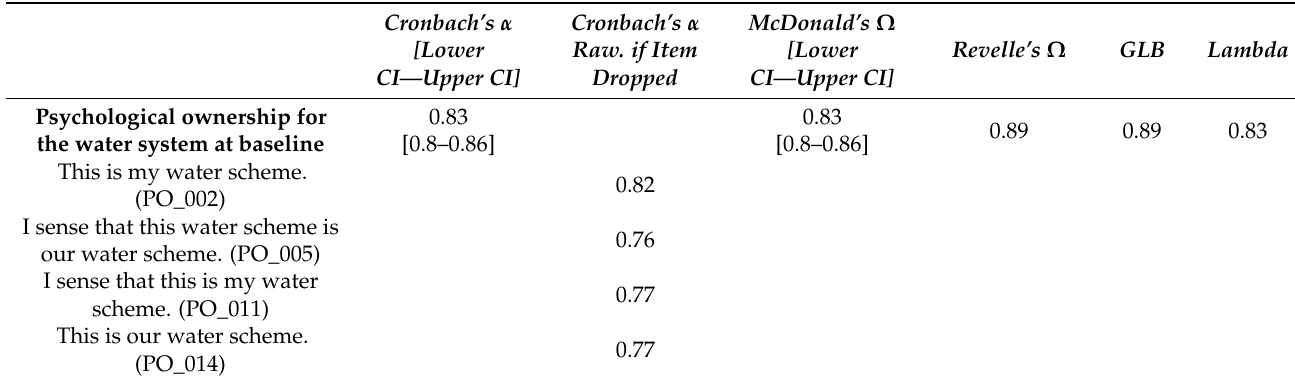
Table 10. Reliability indicators for all items.